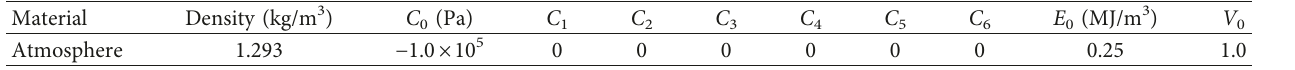
Table 3: Material parameters of air in numerical simulation.